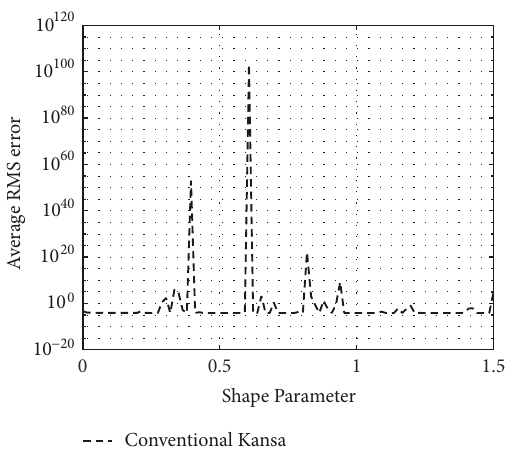
Figure 2: Effect of the Gaussian shape parameter ( 𝜀 ≤ 1.5 ) on the result accuracy for the conventional Kansa scheme computed at Re = 10 with 𝑡 = 0.5, Δ𝑡 = 0.005 , and 𝑁 = 10 × 10